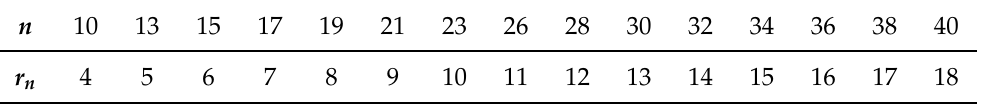
Table 1. Stopping boundaries of the design by Thall and Simon [2], when N = 40, N min = 10, δ = 0.1, π ( p S ) = beta ( p S ;63,94 ) , π ( p E ) = beta ( p E ;1.4,1.6 ) and the nominal level for the type I error rate is